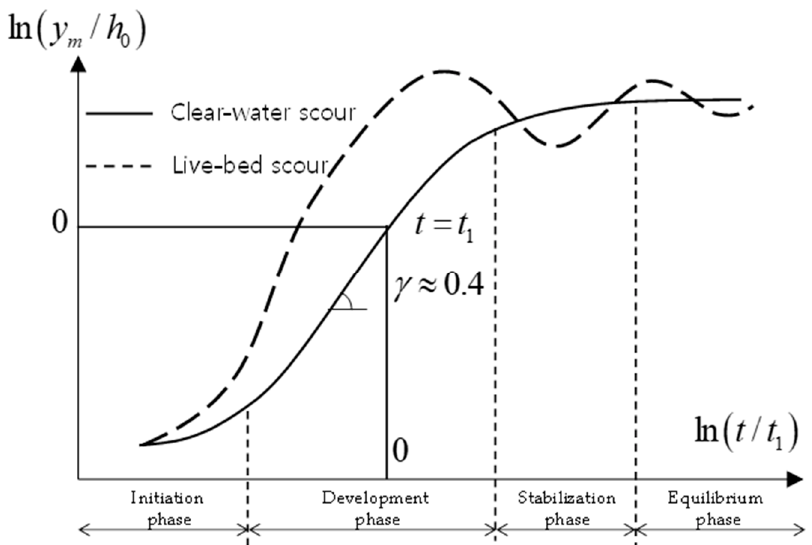
Figure 2. Temporal phases of normalized maximum scour depth [6]. γ is an exponent of the relationship between dimensionless maximum scour depth and time and also the scouring rate.